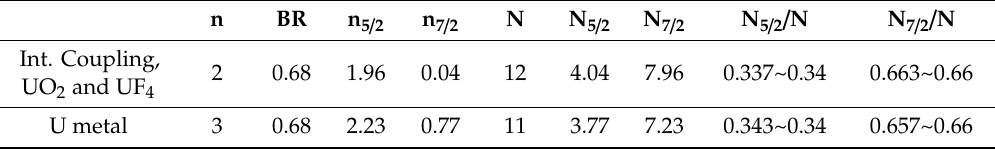
Table 2. XAS branching ratios and 5f